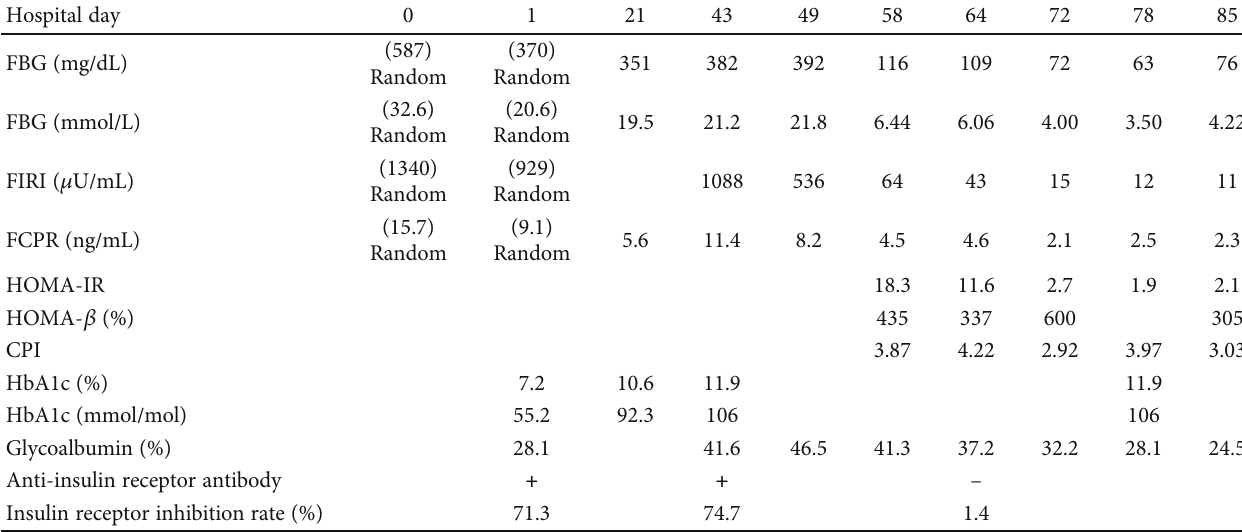
Table 1: Changes in serum levels of FBG, insulin, C-peptide, HbA1c, glycoalbumin, anti-insulin receptor antibody, and insulin receptor inhibition